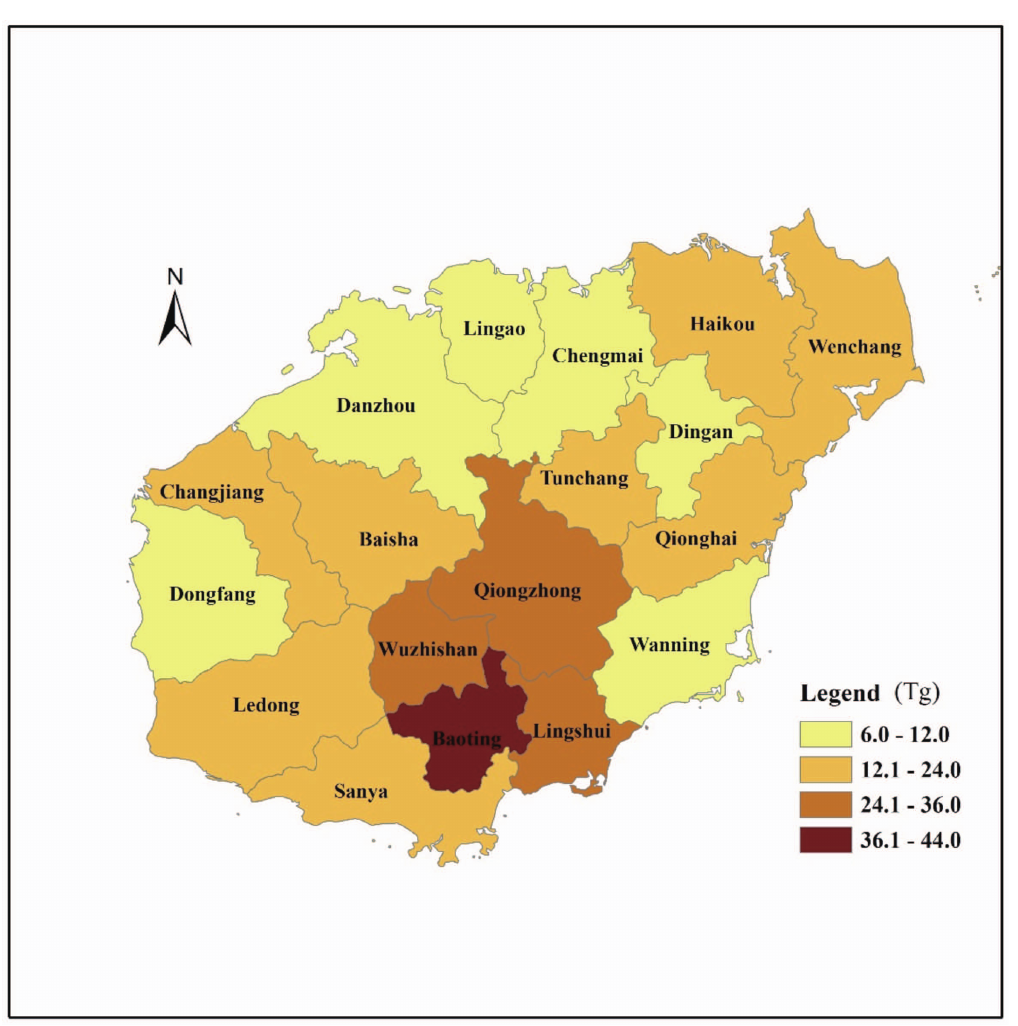
Figure 5. The spatial distribution of forest ecosystem C storage on Hainan Island in 2008.